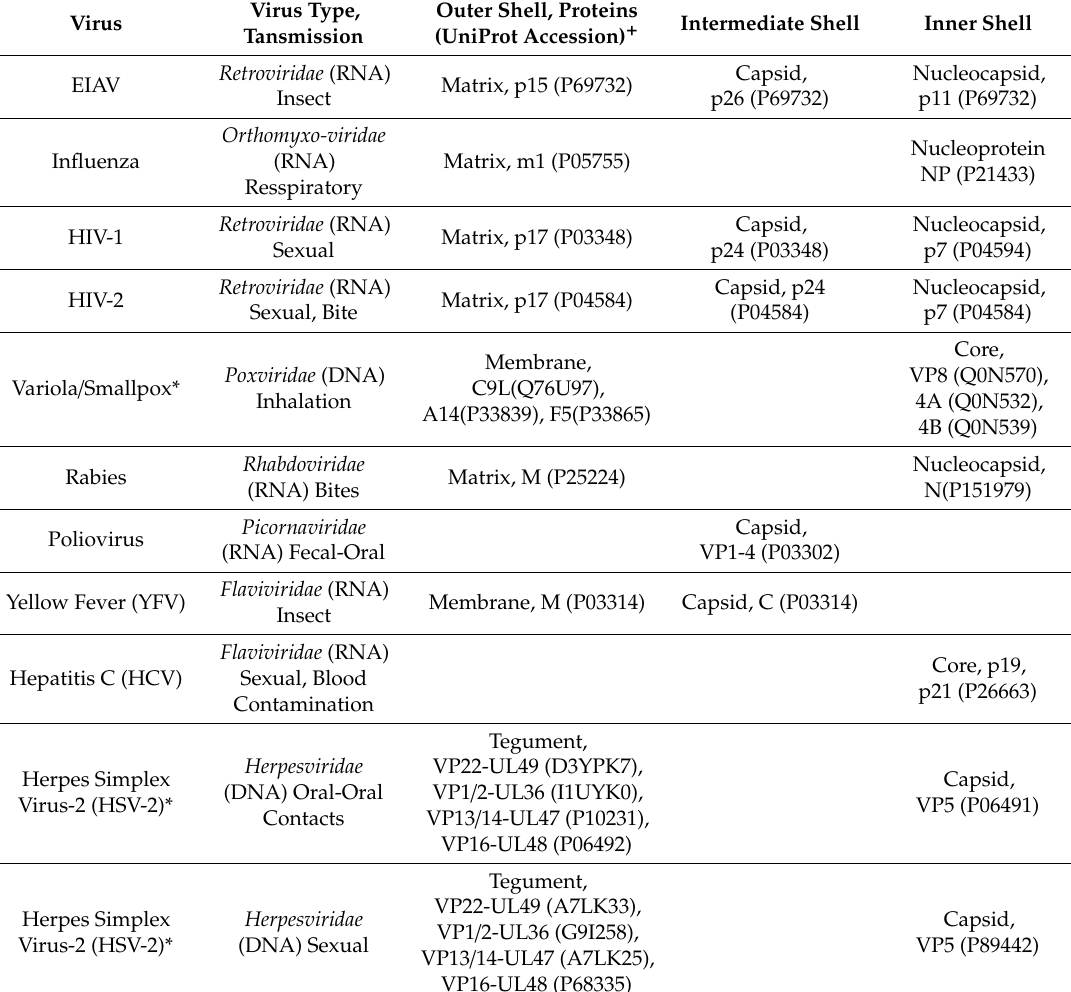
Table 1. Viruses with sample UniProt accession codes for shell